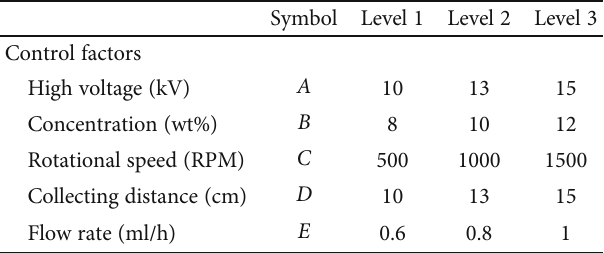
Table 2: Electrospinning control factors and levels. Table 3: Experimental plan for fi ber diameter analysis of PVP nano fi bers using L27 orthogonal